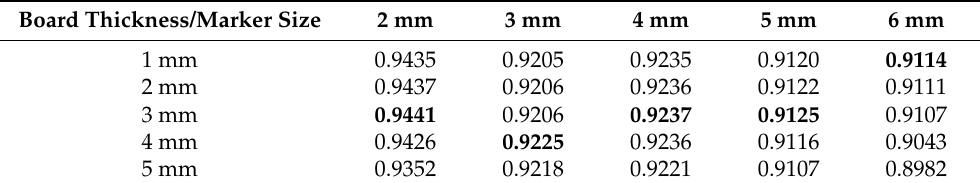
Figure 8. Close-up image of the projection of the calibration checkerboard ( left ). Close-up image of the projection of spherical marker ( right ). The red cross is the ground truth image point; the blue circle is the detected image point. Table 3. SSIM of the reconstructed volume with ground truth reconstructed volume for each configuration pair. For each marker size, the board thickness that resulted in the best SSIM are marked in bold.